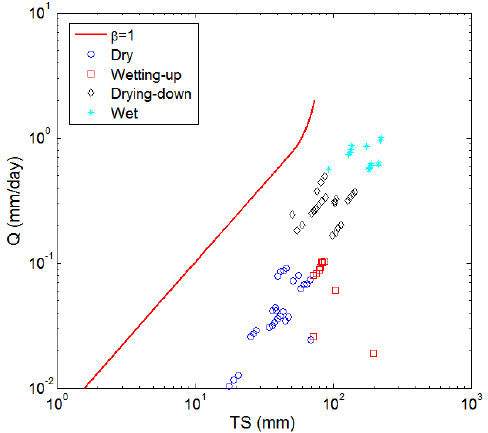
Fig. 12. The impact of variable contributing storage on the total storage-discharge relationship at the Spoon River watershed in 4 storage stages.